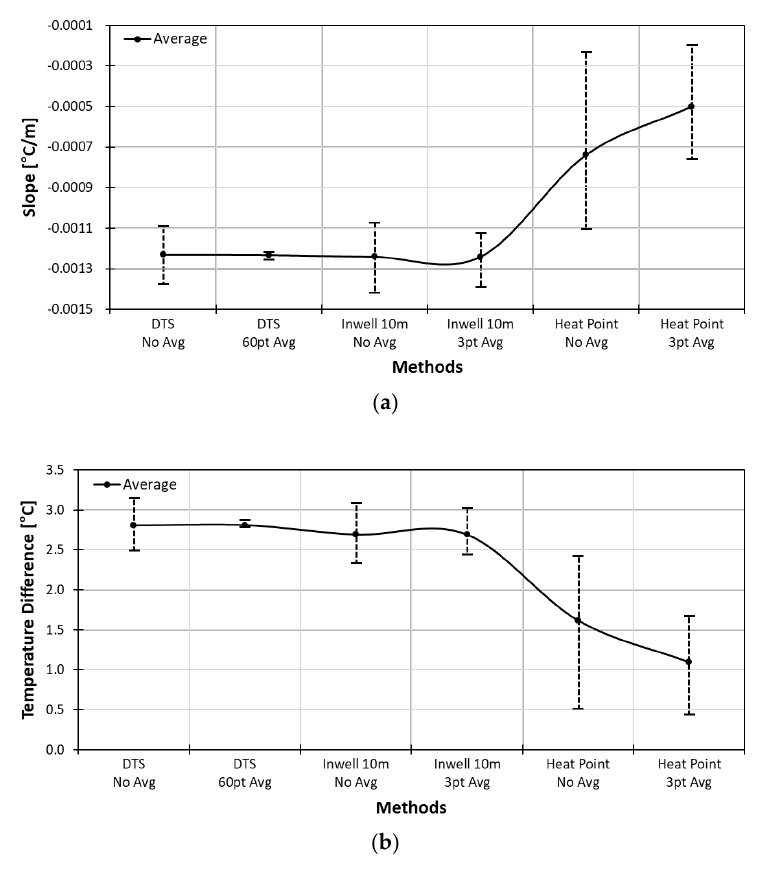
Figure 13. Slope curves ( a ) and temperature difference ( b ) of post-calibration method.